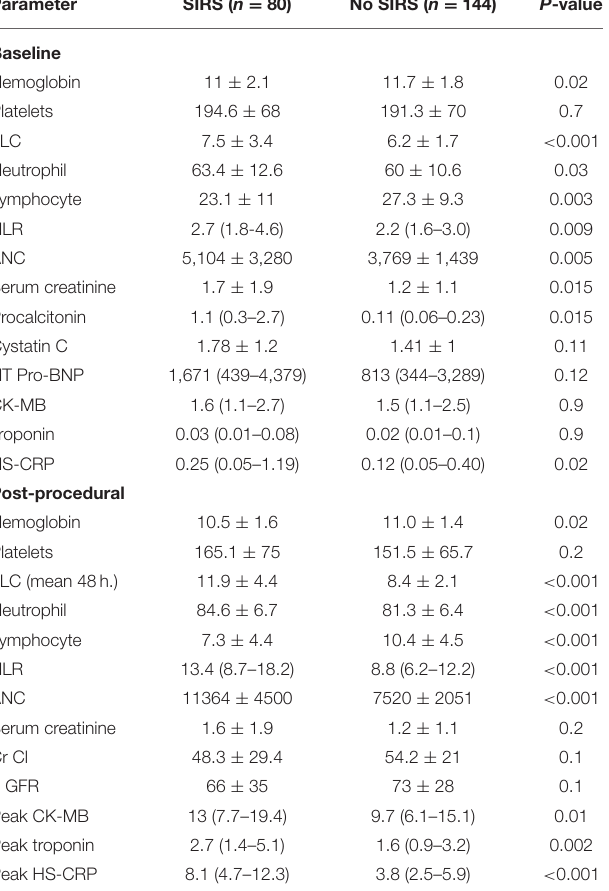
TABLE 2 | Baseline and follow-up laboratory investigations. Parameter